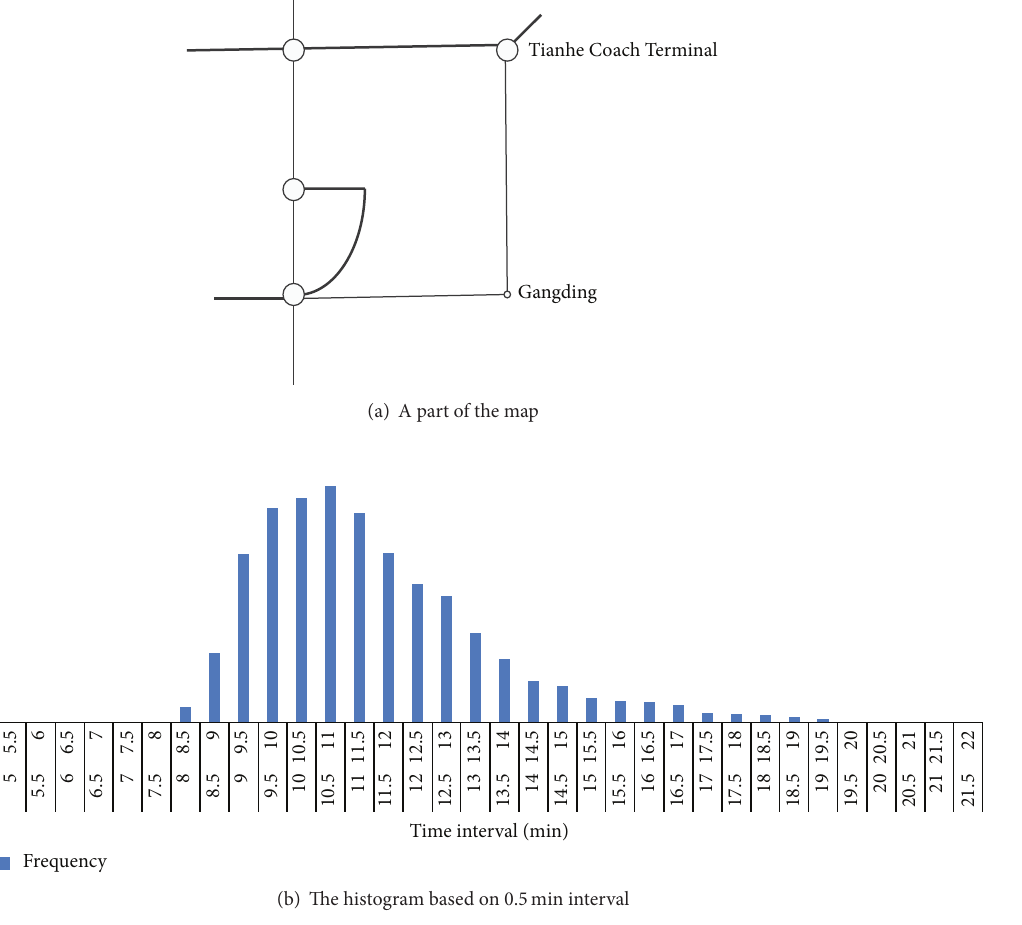
Figure 4: An example for the travel time distribution from Tianhe Coach Terminal to